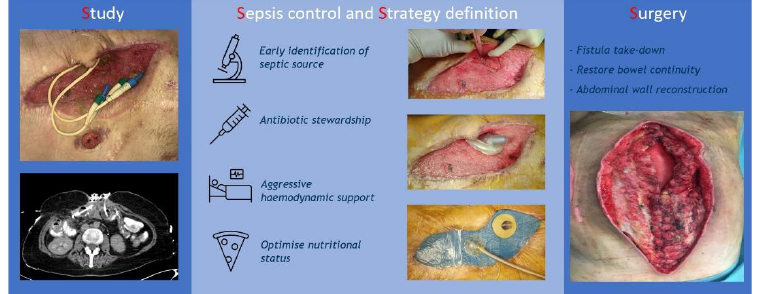
Figure 1. Three-step standardised approach to CEF.